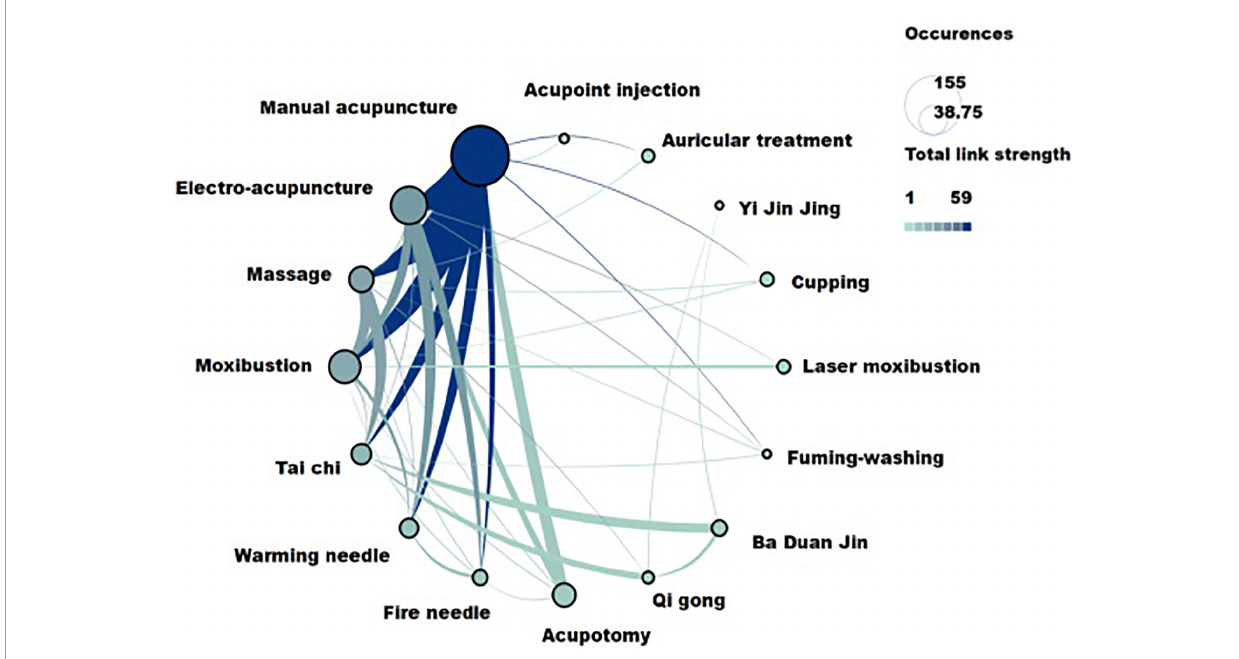
FIGURE9 The therapies with co-occurrence frequency greater than five related to traditional Chinese non-pharmacological therapies on knee osteoarthritis (KOA).